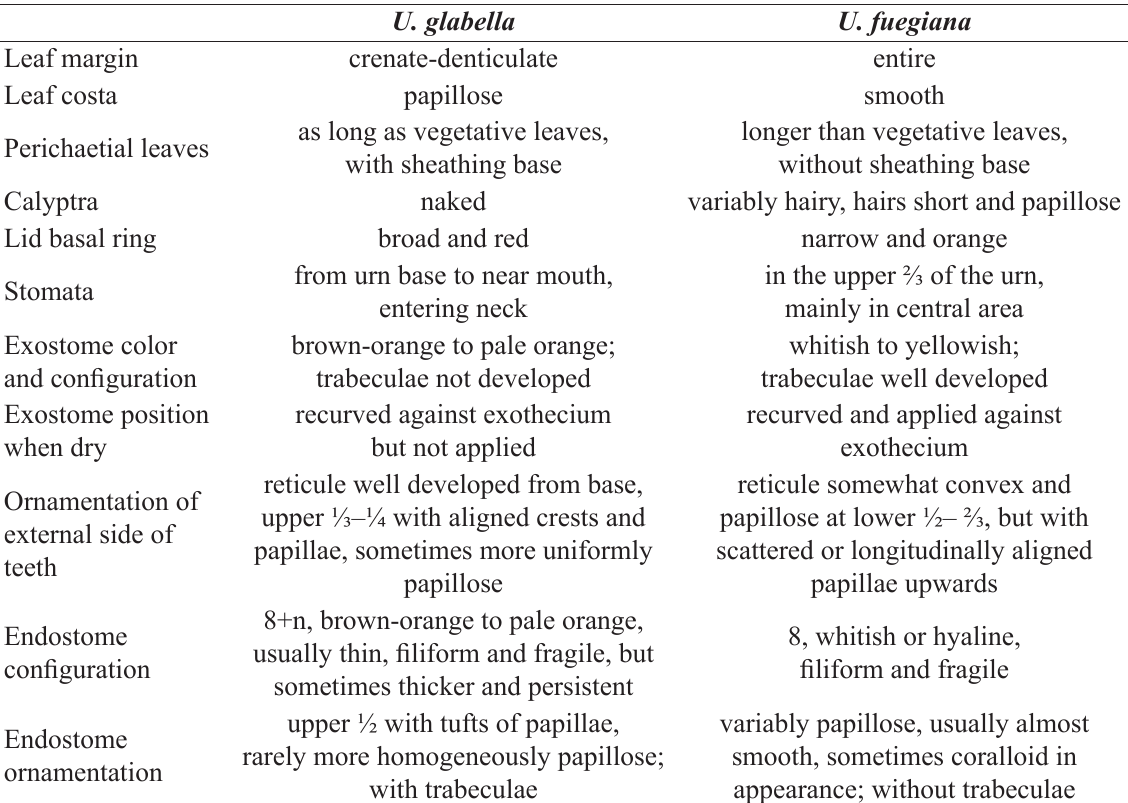
Table 2. Main differential characters between Ulota glabella Mitt. and U. fuegiana